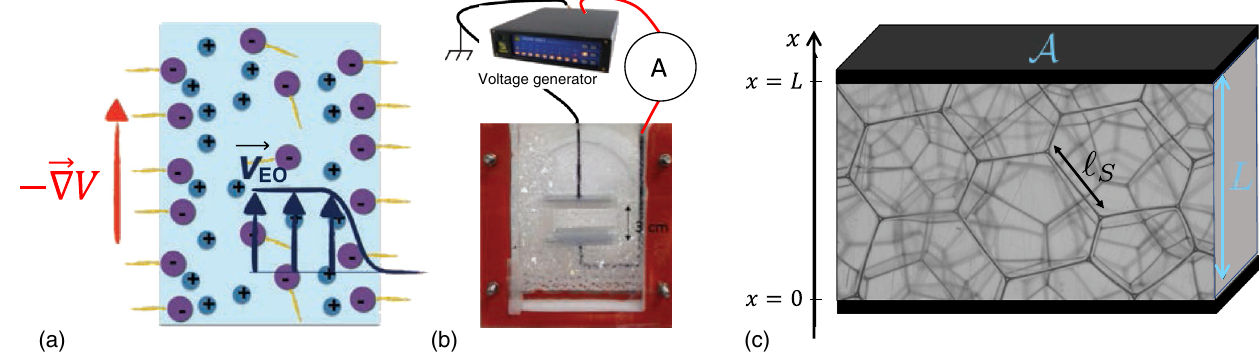
FIG. 1. (a) Scheme of electro-osmotic flow that takes place in a foam film. (b) Experimental setup allowing the study of electrokinetic transport in a macroscopic foam. (c) Side view picture of the foam between the electrodes; the focus is on the front plate.